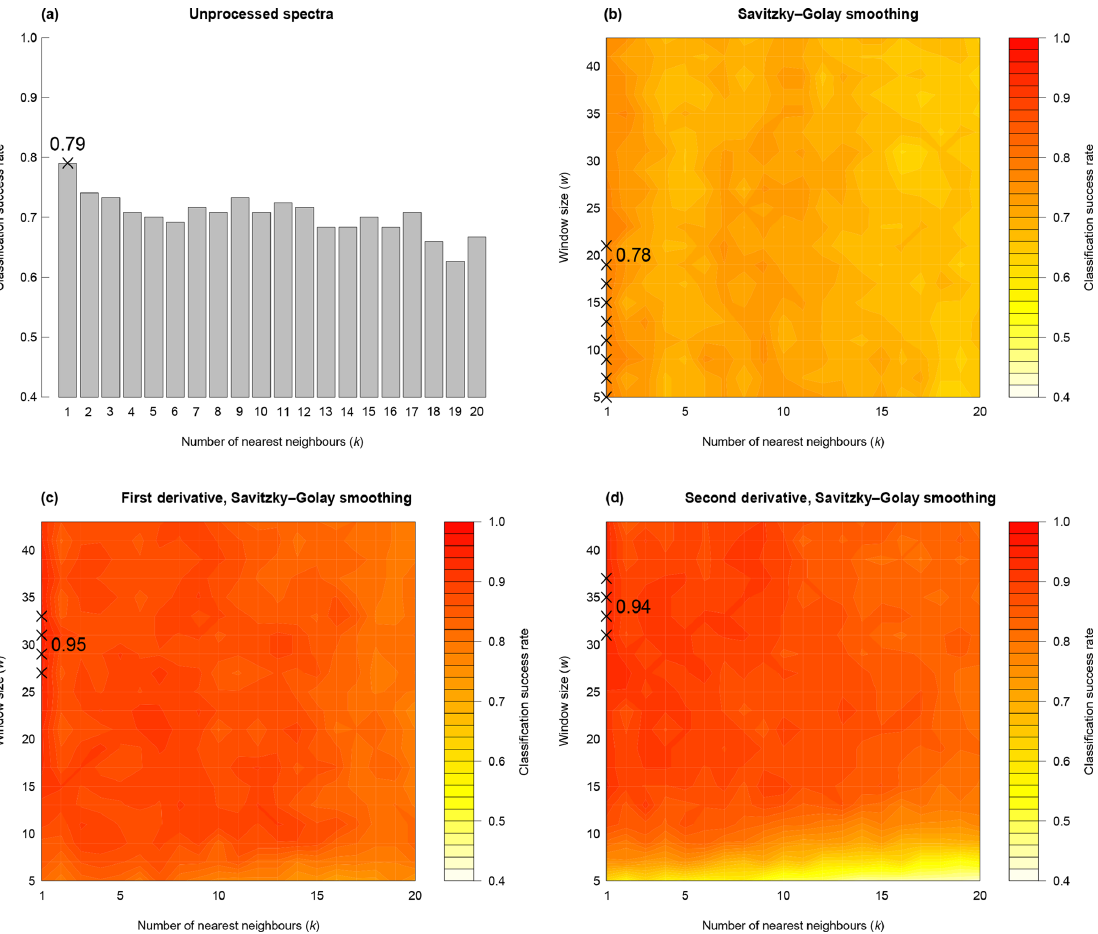
Figure 4. Classification success rate with variations in number of nearest neighbours ( k ), smoothing window size ( w ) and differentiation ( m ). In each panel crosses show the parameter combinations with the highest classification success rate. For (b) to (d) , hotter colours denote a higher classification success rate.